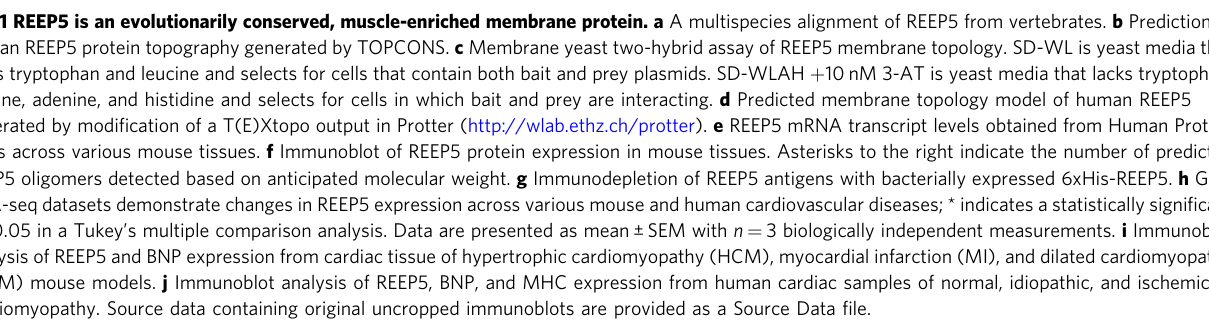
Fig. 1 REEP5 is an evolutionarily conserved, muscle-enriched membrane protein. a A multispecies alignment of REEP5 from vertebrates. b Prediction of human REEP5 protein topography generated by TOPCONS. c Membrane yeast two-hybrid assay of REEP5 membrane topology. SD-WL is yeast media that lacks tryptophan and leucine and selects for cells that contain both bait and prey plasmids. SD-WLAH + 10 nM 3-AT is yeast media that lacks tryptophan, leucine, adenine, and histidine and selects for cells in which bait and prey are interacting. d Predicted membrane topology model of human REEP5 generated by modi fi cation of a T(E)Xtopo output in Protter (http://wlab.ethz.ch/protter). e REEP5 mRNA transcript levels obtained from Human Protein Atlas across various mouse tissues. f Immunoblot of REEP5 protein expression in mouse tissues. Asterisks to the right indicate the number of predicted REEP5 oligomers detected based on anticipated molecular weight. g Immunodepletion of REEP5 antigens with bacterially expressed 6xHis-REEP5. h GEO RNA-seq datasets demonstrate changes in REEP5 expression across various mouse and human cardiovascular diseases; * indicates a statistically signi fi cant p < 0.05 in a Tukey ’ s multiple comparison analysis. Data are presented as mean ± SEM with n = 3 biologically independent measurements. i Immunoblot analysis of REEP5 and BNP expression from cardiac tissue of hypertrophic cardiomyopathy (HCM), myocardial infarction (MI), and dilated cardiomyopathy (DCM) mouse models. j Immunoblot analysis of REEP5, BNP, and MHC expression from human cardiac samples of normal, idiopathic, and